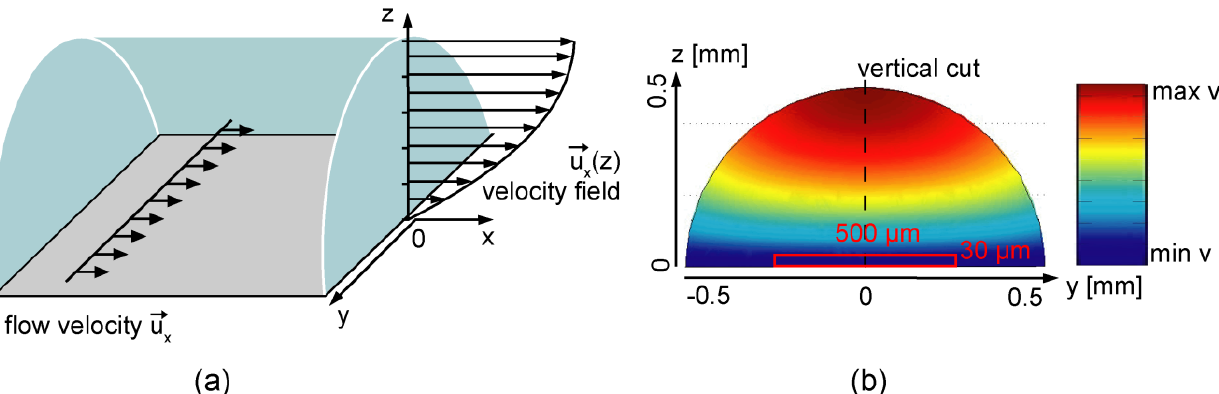
Figure 2. ( a ) Scheme of the flow geometry; ( b ) the cross-sectional view of the calculated flow velocity